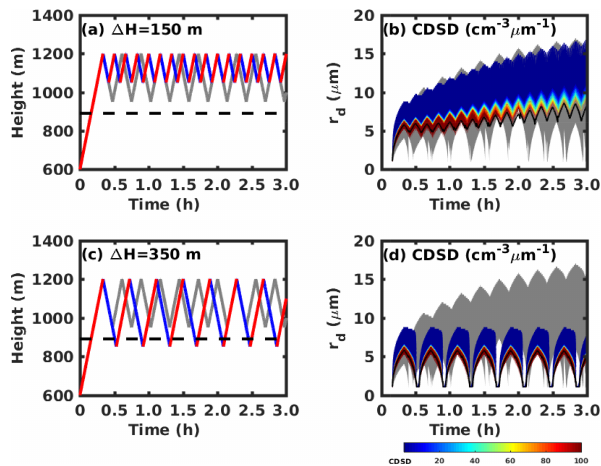
Figure 6. (a) The height of cloud parcel changes with time for the thin recirculation layer of 150m. (b) Cloud droplet size distribution changes with time for the thin recirculation layer case. (c) Aerosol size distribution for the thick recirculation layer of 350m. (d) Cloud droplet size distribution changes with time for the thick recircula- tion layer case. Red and blue lines in (a) and (c) represent as- cending and descending parcels, and gray lines in represent the con- trol case with recirculation layer of 250m. The gray regions in (b) and (d) are the range of cloud droplet size spectrum for the control